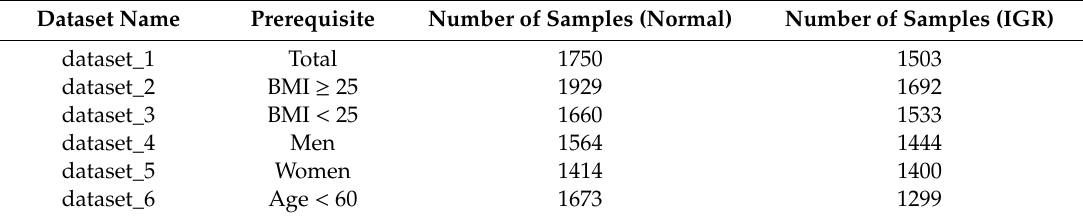
Figure 1. Steps of electrocardiogram (ECG) preprocessing: ( A ) ECG of a normal person; ( B ) ECG of a patient with prediabetes; ( C , E , G ) are the images after performing the left top, right bottom, and center cropping operations using ( A ), respectively; ( D , F , H ) are the images after performing the left top, right bottom, and center cropping operations using ( B ), respectively. Table 3. The composition of the training sets after data augmentation in this paper.